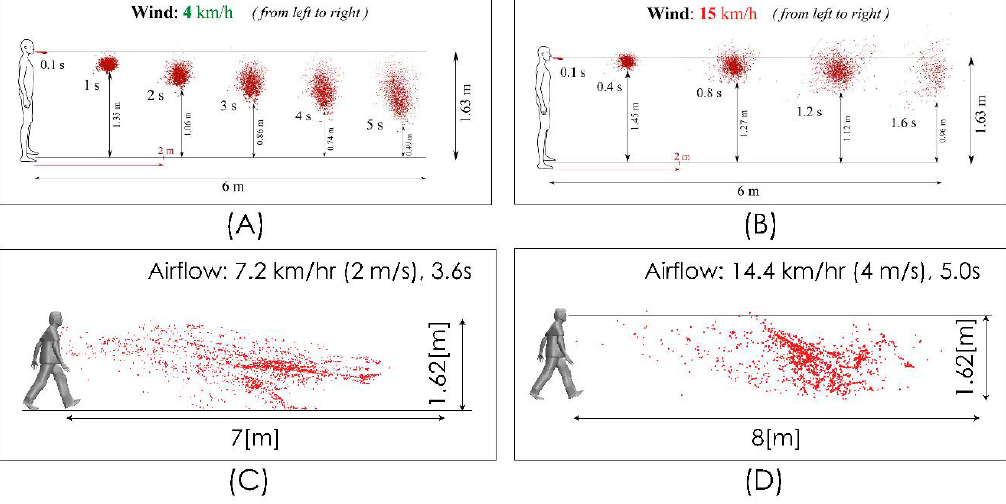
Figure 6. Comparison of droplet propagation range. 4 km/h (1.1 m/s) from [25] ( A ); 15 km/h (4.1 m/s) from [25] ( B ); current predictions 2 m/s ( C ); current predictions 4 m/s ( D ).